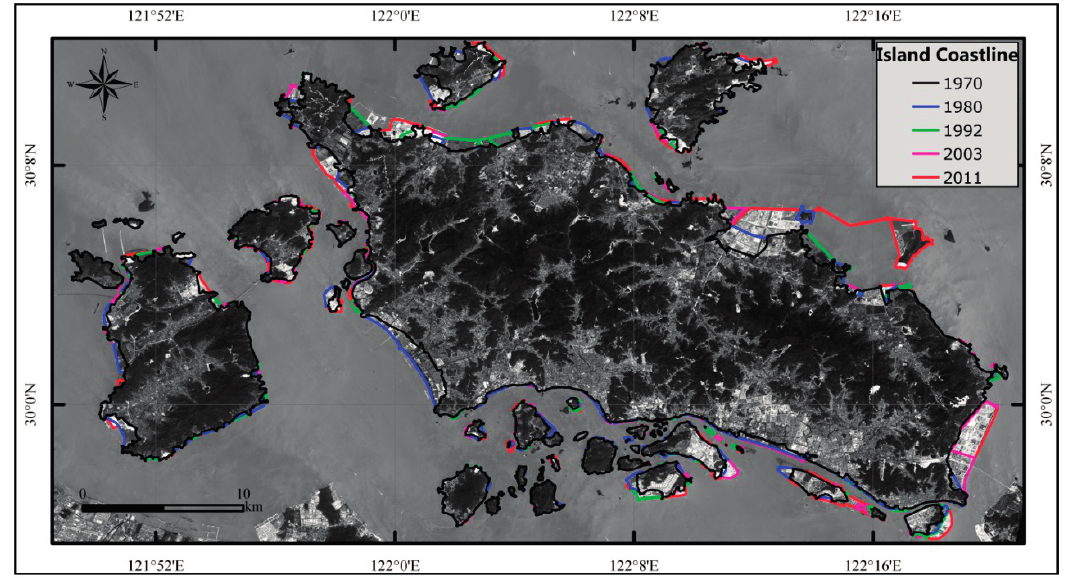
Figure 3. Multi-temporal coastline maps for the Zhoushan Islands during 1970–2011.